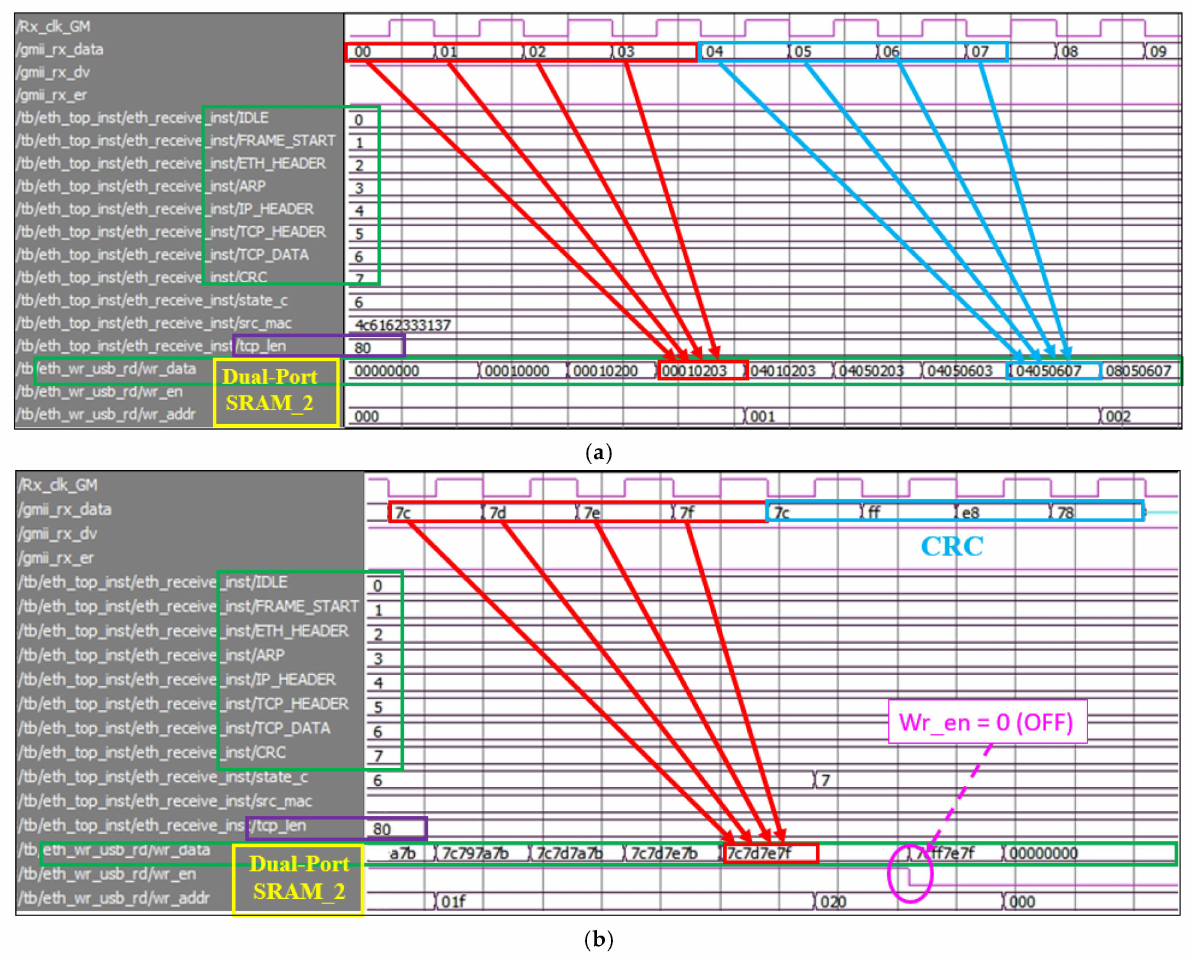
Figure 11. The received Ethernet Modbus/TCP packets are stored in SRAM as a 32-bit serial data. ( a ) The first group of Ethernet packets and its 32-bit serial data; ( b ) the last group of Ethernet packets and its 32-bit serial